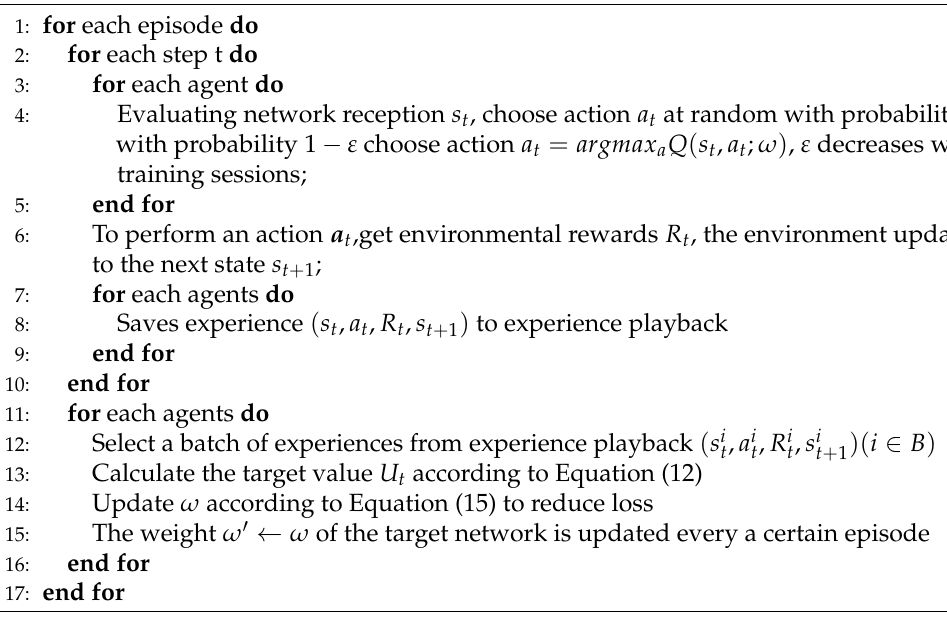
Algorithm 1 Task scheduling algorithm based on